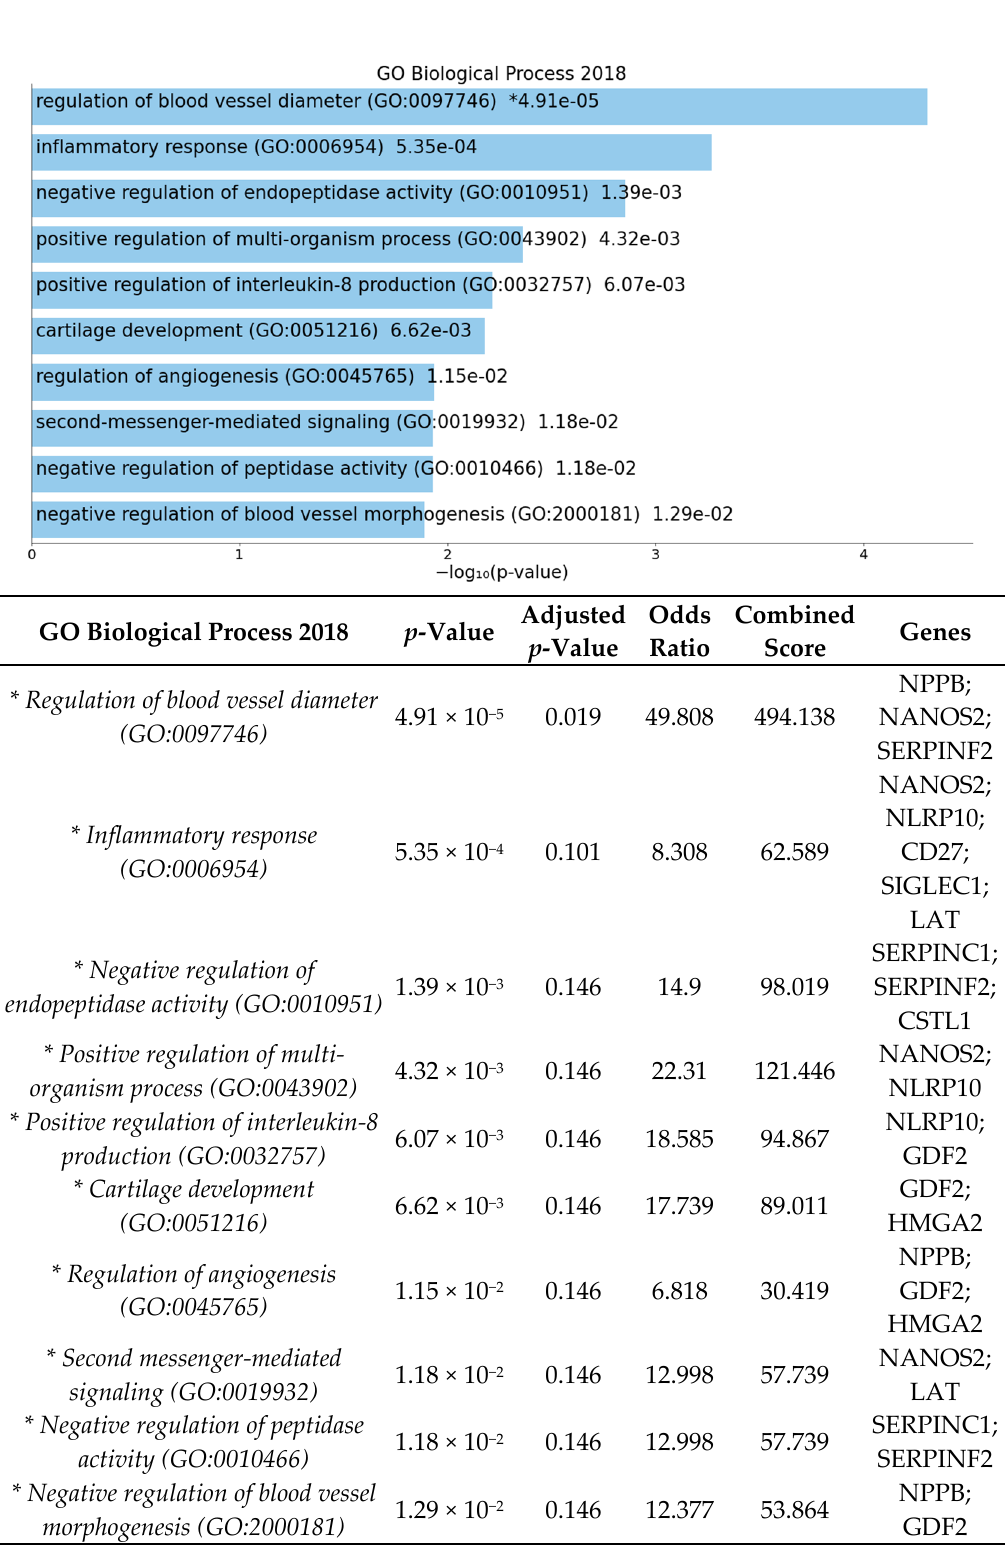
Figure 4. Gene list enrichment analysis of significant DEGs between GF-HFD mice ( n = 4) and GF-ND mice ( n = 4) using EnrichR. The bar graph shows a ranked list by p -value of the top 10 over-represented biological processes with significant processes indicated in blue ( p -value < 0.05). The corresponding table demonstrates detailed statistics and involved genes with significant processes indicated by an asterisk ( p -value < 0.05).